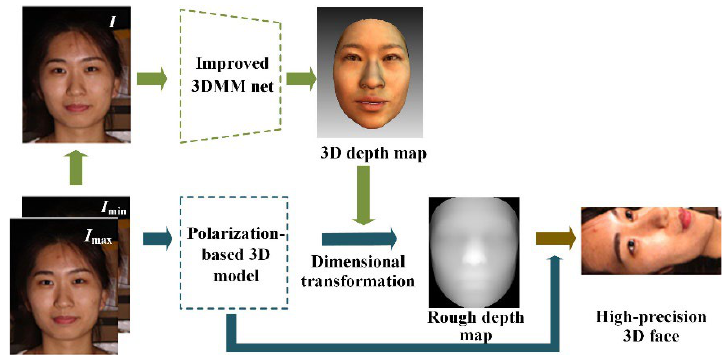
Figure 1. Overall schematic of the 3D face reconstruction method.